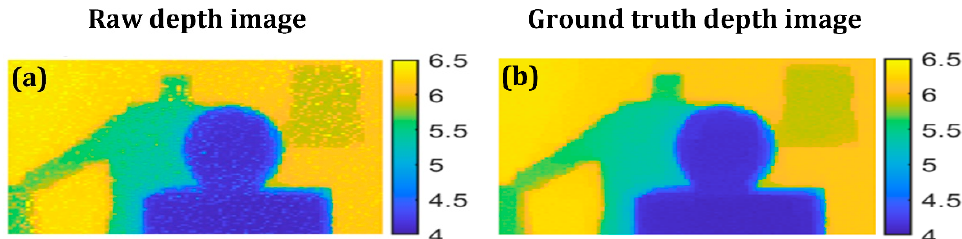
Figure A2. Depth image from dark experiment dataset. ( a ) Reconstruction using the mean of counts without dark noise counts filtering. ( b ) Reconstruction using the mean of counts with dark noise counts filtering.